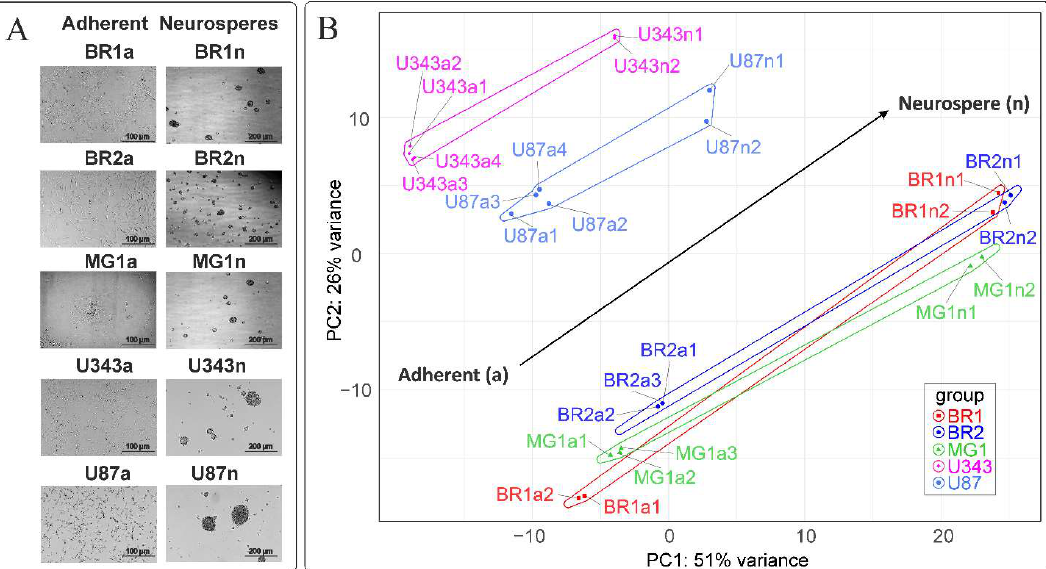
Figure 1. ( A ) Representative images of MN (adherent) and NS glioma cells before cell collection for NGS RNAseq analysis. ( B ) Principal component analysis of DESeq2 normalized, variance stabilizing transformed (VST) gene expression data. Cell line-specific PC1:PC2 points are annotated with cell line-defined envelopes. The black arrow shows the general trend of PC1:PC2 transition from the MN state to the NS state.